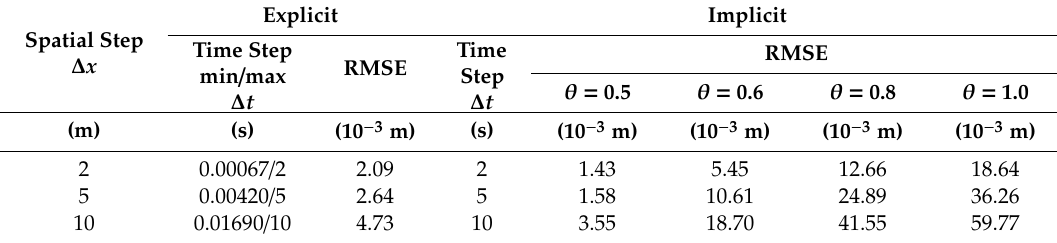
Table 1. Impact of the space interval ∆ x , time interval ∆ t , and spatial approximation weighting parameter θ on the accuracy of the numerical solution obtained using the implicit and explicit schemes with